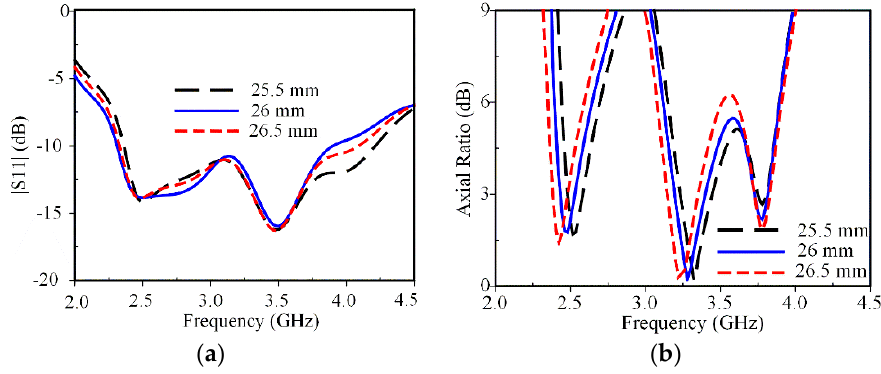
Figure 6. Effect of W 1 on antenna performances: ( a ) S11; ( b ) axial ratio. Figure 6. E ff ect of W 1 on antenna performances: ( a ) S11; ( b ) axial